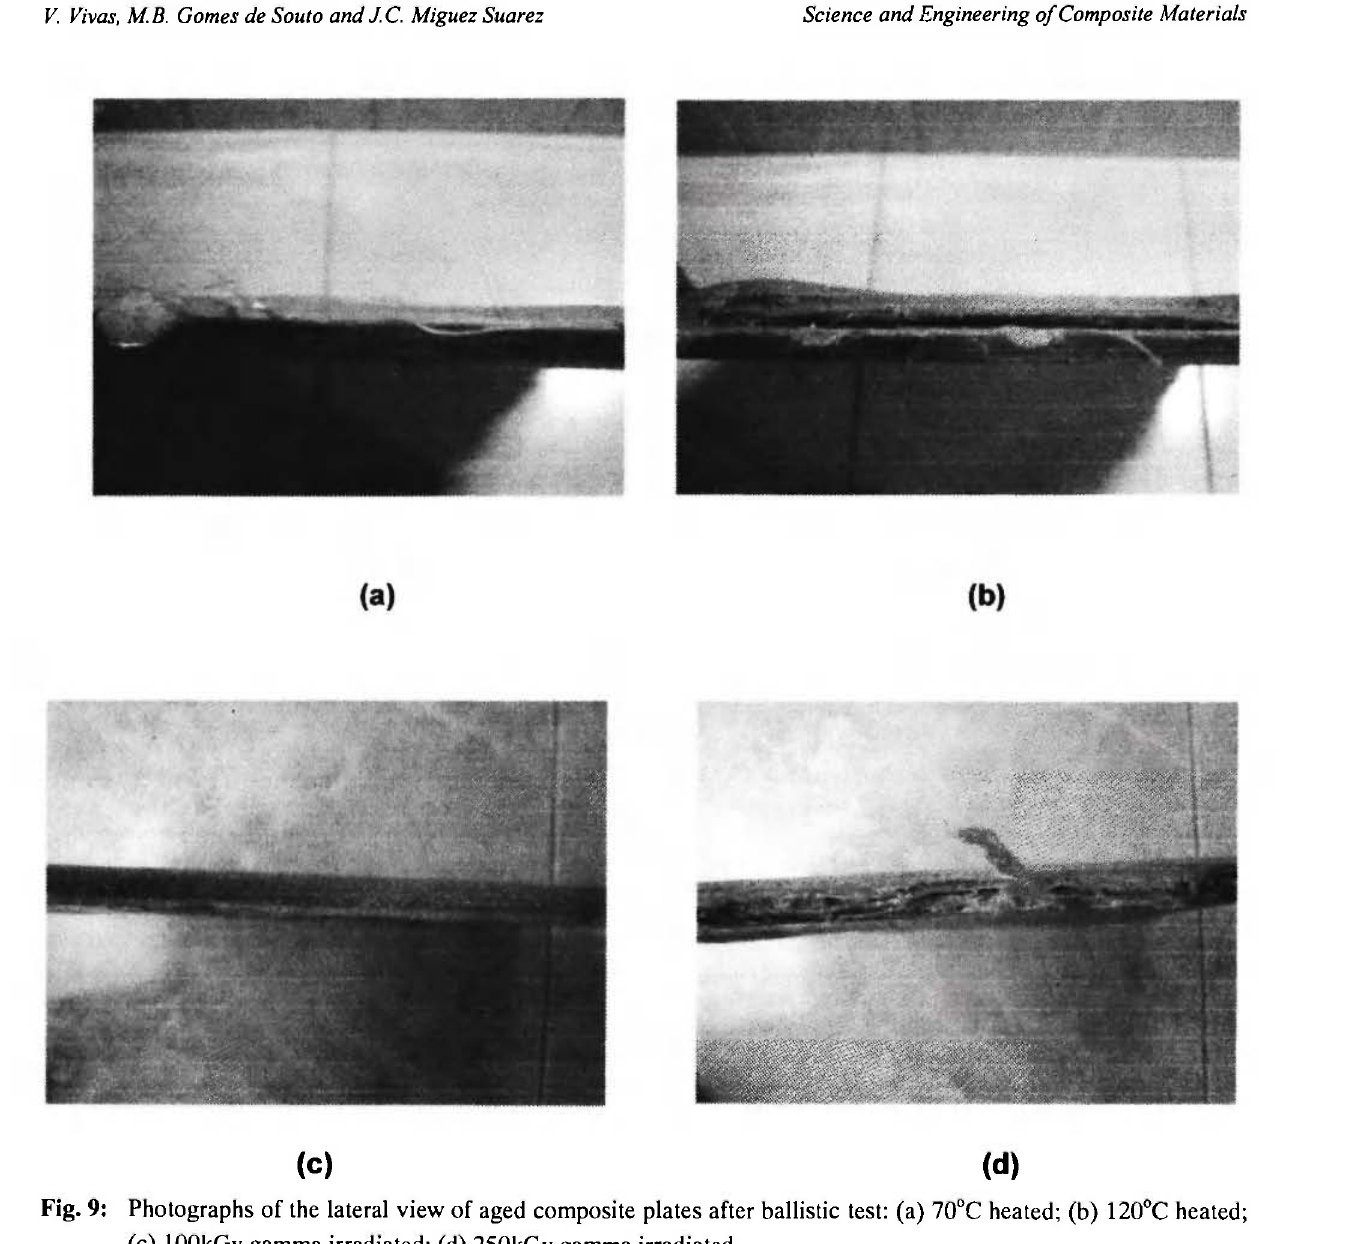
Fig. 9: Photographs of the lateral view of aged composite plates after ballistic test: (a) 70°C heated; (b) 120°C heated; (c) lOOkGy gamma irradiated; (d) 250kGy gamma irradiated